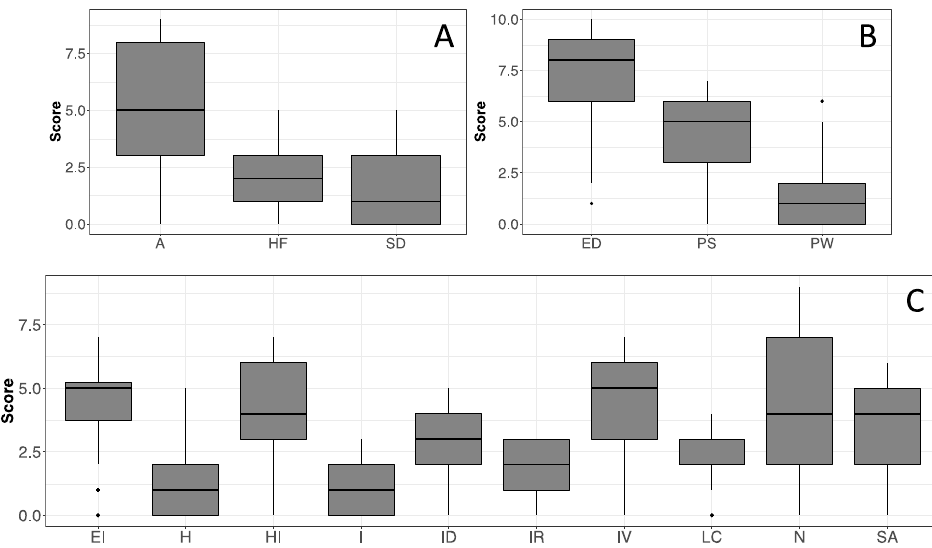
Figure 2. Boxplots of the scores obtained in each scale of the CBA-H. Scale legends with Cronbach’s